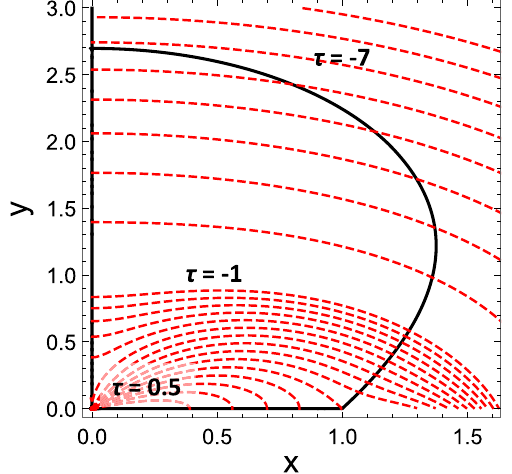
FIG. 11. Contours of the real (red dashed) and imaginary (solid black) parts of the complex function in (33), illustrating the locations of fixed points in one quadrant of the transverse plane for all values of τ . The origin is always a fixed point. The remaining fixed points move over the solid black curves as τ varies. Dashed red curves are shown for decreasing values of τ ranging from τ ¼ 0 . 5 to τ ¼ − 1 (in decrements of 0.1) and from τ ¼ − 1 to τ ¼ − 9 (in decrements of 1).